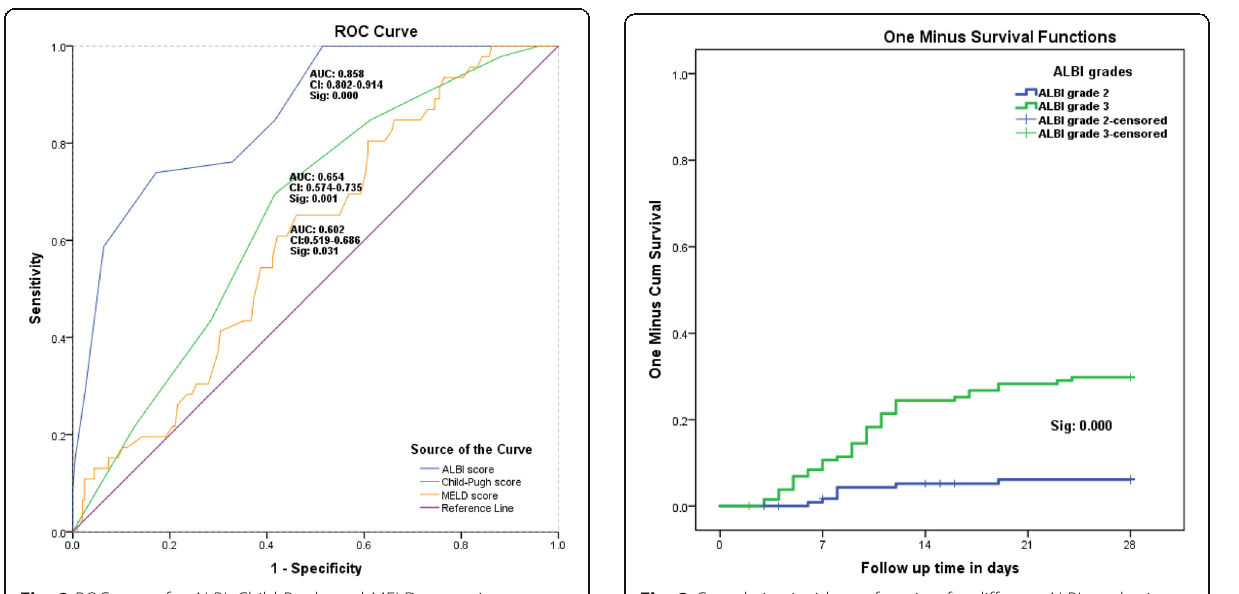
Fig. 3 Cumulative incidence function for different ALBI grades in prediction of hepatic